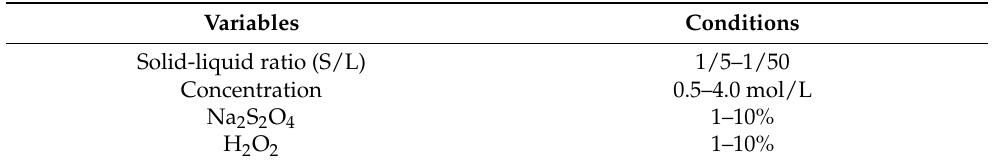
Table 1. Parameters studied in the direct leaching experiments for the extraction of rare-earth elements from silicate-based ore.